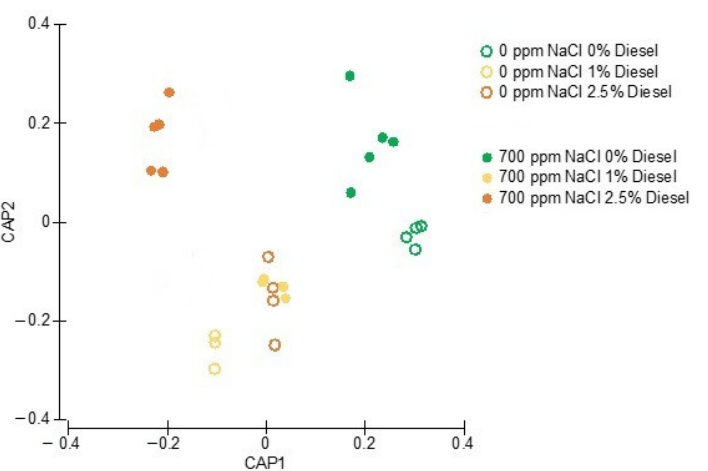
Figure 7. Canonical Analysis of Principal (CAP) components based in the Kautsky curve fluorescence data points of the J. acutus samples exposed to diesel with (empty circles) and without (filled circles) NaCl supplementation.